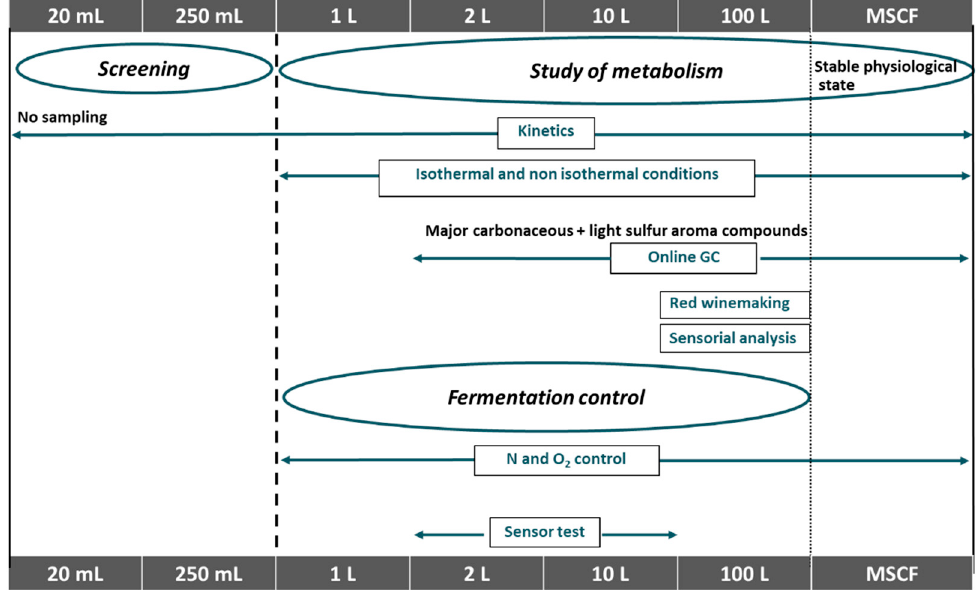
Figure 9. Which equipment for which research question? Choice of the scale (from 20 mL to 100 L) and the equipment level (possibility of different online monitoring and control systems) according to (i) the research topic (screening, study of metabolism, or fermentation control) and (ii) specific needs (sensory analysis, red winemaking conditions, sensor test). MSCF: multistage continuous fermenter.